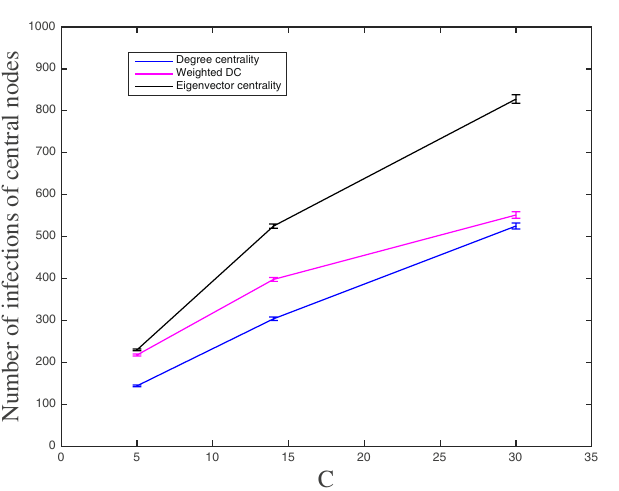
Figure 13. The mean number of infections of the C central nodes (and 95% confidence intervals) during an epidemic under the different selection strategies for C = 5, 14, and 30. Total time of the simulations: 250